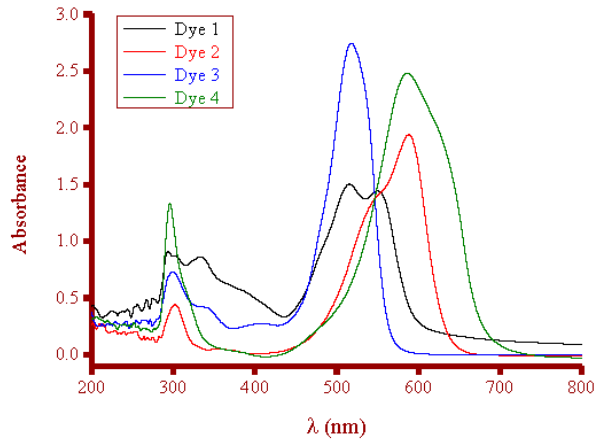
Figure 8. The electronic spectra of Dye 1, Dye 2, Dye 3, and Dye 4 in aqueous solution (10 mg/100 mL) at pH 7.